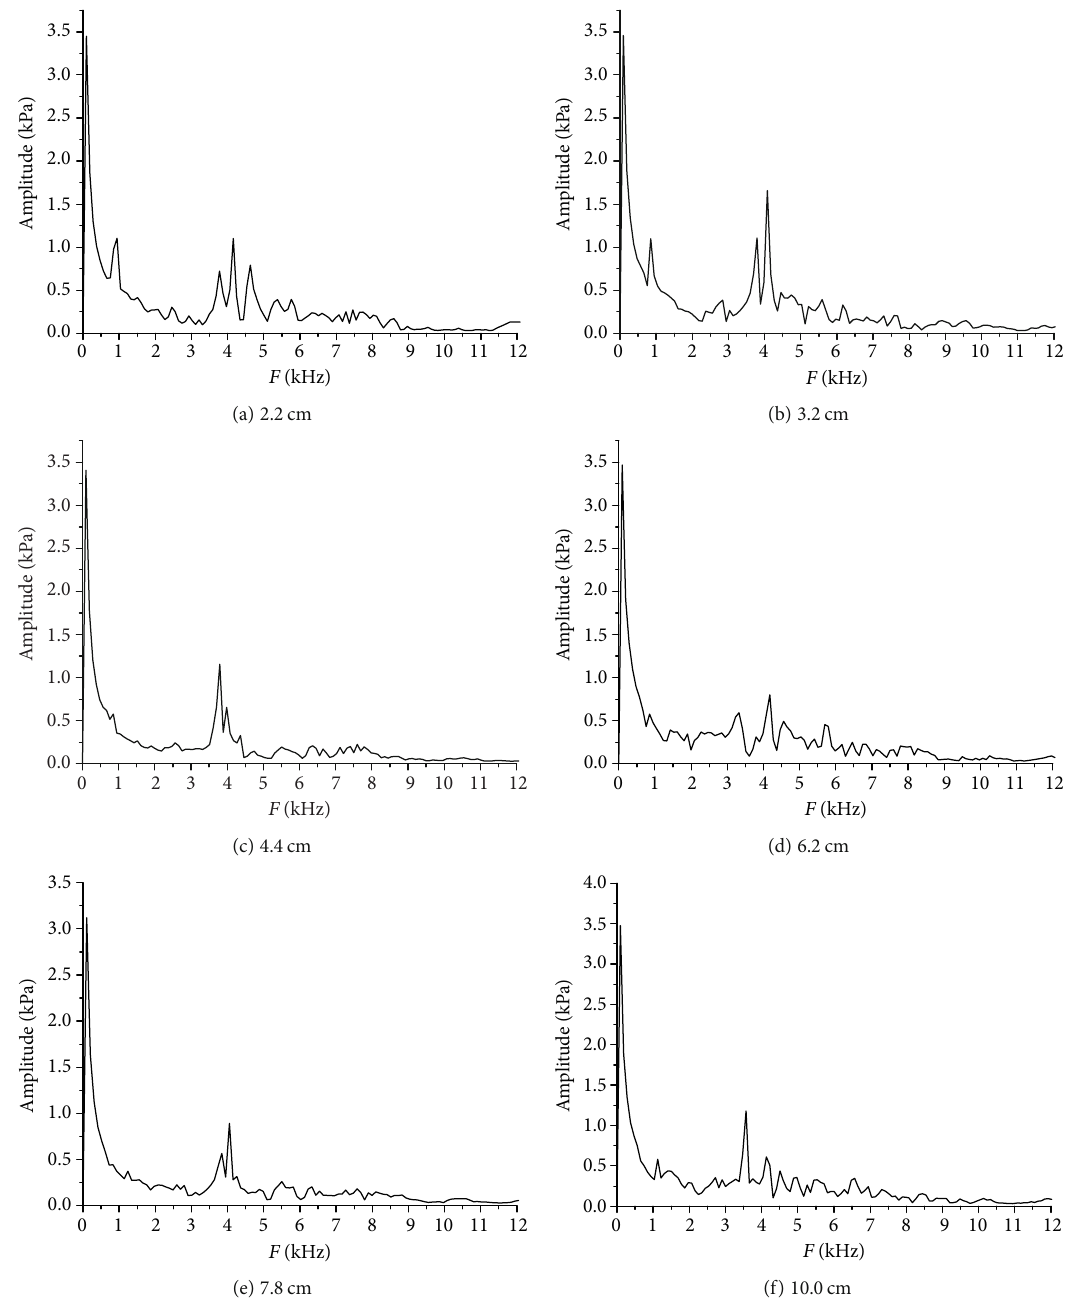
Figure 6: FFT analysis of pressure oscillations at the observation point for the Model B chamber with di ff erent injector injector is roughly half of the eigenfrequency of the 2L2T acoustic mode, so the injector may play as a half-wave reso- nator of the 2L2T mode. For the case of injector length with 4.4 cm, the tuning frequency closes to the eigenfrequency of 1L acoustic modes, and the pressure oscillation of the 1L acoustic mode is inhibited completely, while it does not work for the other acoustic modes. For the case of injector length with 6.2 cm, the tuning frequency is keeping close to the eigenfrequency of 1L acoustic modes much more, and the